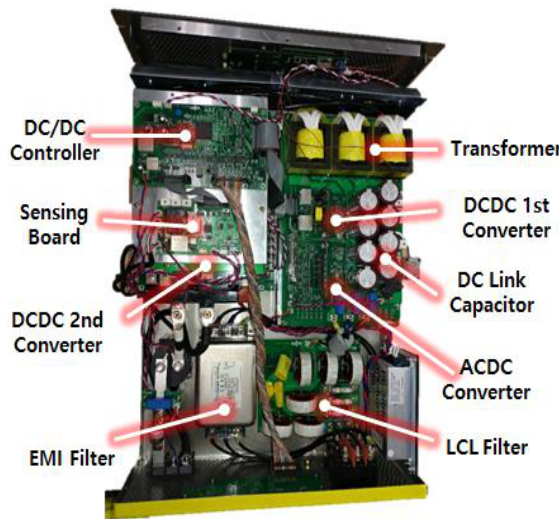
Figure 17. Hardware configuration of 3P-CFDAB converter.